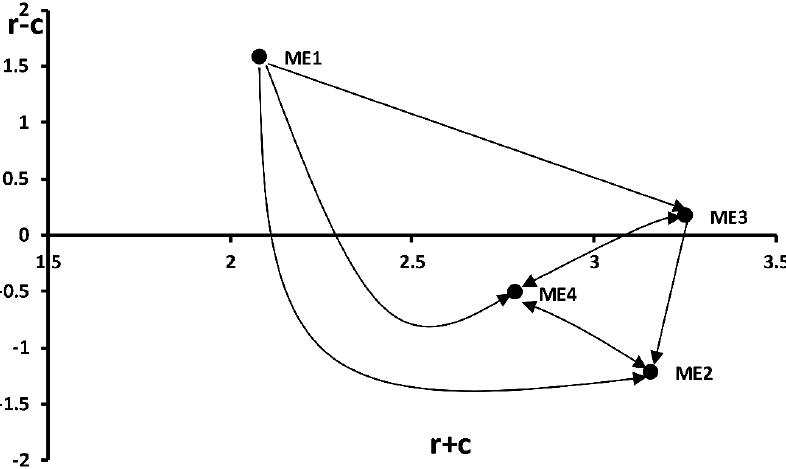
Figure 6. The cause and effect relationship map for mechanical FMs.